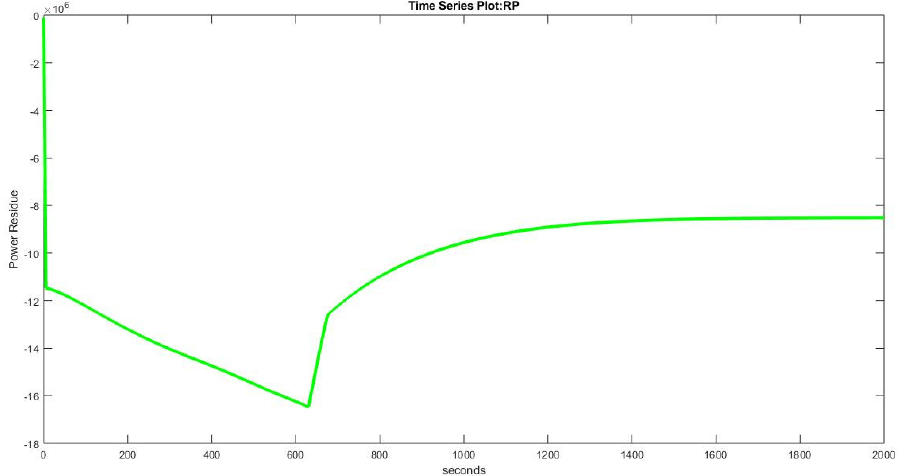
Figure 17. Power residue for the saturation fault of turbine gate 𝐺 .